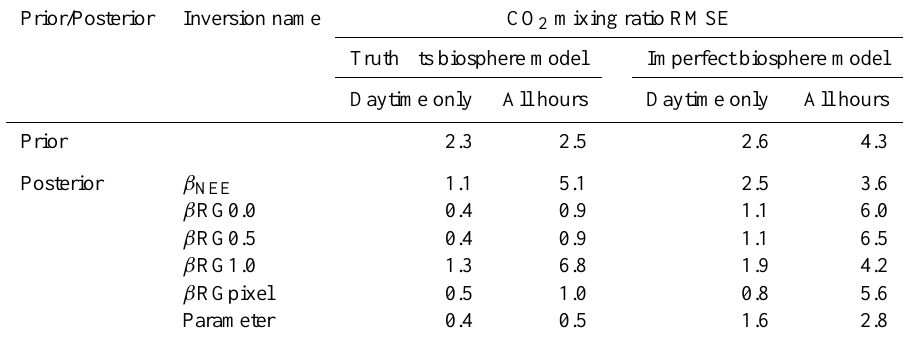
Table 4. The performance of the six inverse methods expressed as the RMSD of the time series of the atmospheric CO 2 mixing ratio related to the optimized NEE flux fields compared to the pseudo observations [ppm]. For the times the observations are used in the inversions (daytime only) and for the total time series (all hours). The left part of the table shows the results of the control inversions, the right part shows the results of the inversions where the truth is generated with a different biosphere model than the